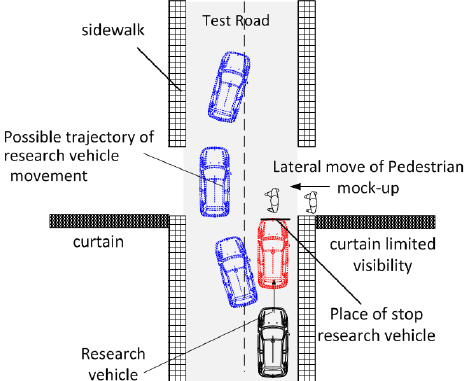
Fig. 5. Photos from the realization of ‘Scenario